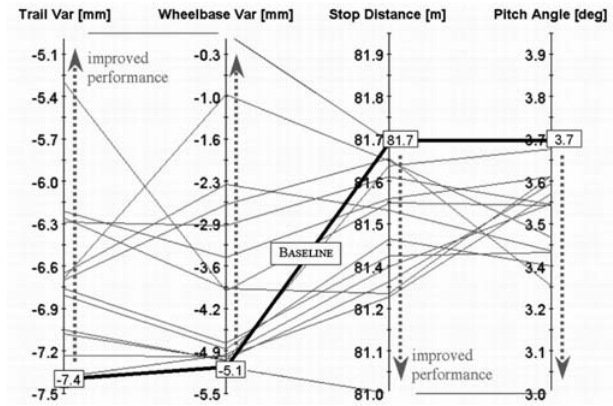
Fig. 9. Parallel chart to identify the best design